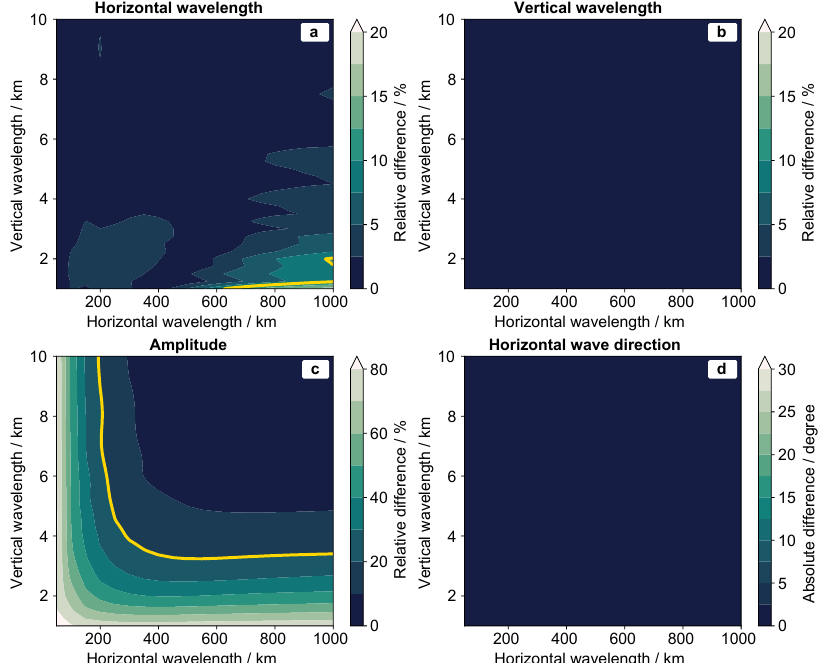
Figure 4. Specific observational filters for (a) horizontal wavelength λ h , (b) vertical wavelength λ z , (c) temperature amplitude ˆ T , and (d) horizontal wave direction ϕ for the FAT retrieval. The yellow lines mark errors of 10% for the horizontal wavelength (a) and 20% for the amplitude (c)